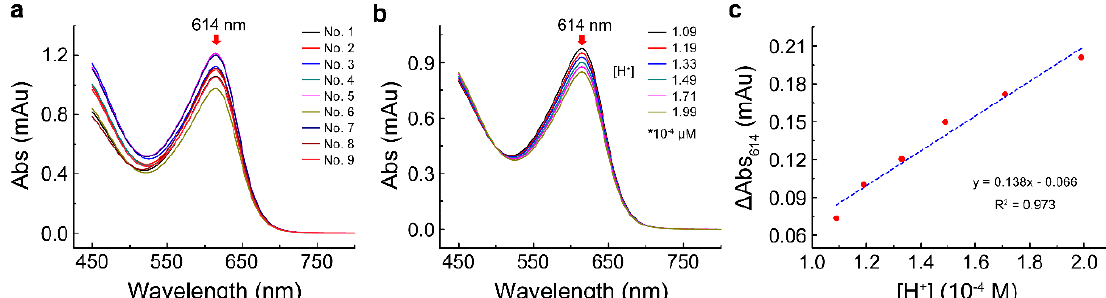
Figure 2. The maximum absorption wavelength of the reaction mixture and its relationship with the hydrogen ion concentration. ( a ) The absorption spectra of nine different combinations in the presence of 5 mM MgAC 2 ; ( b ) effect of hydrogen ion concentration on the absorption of the reaction system; ( c ) the correlation of the absorbance change of bromothymol blue at 614 nm with hydrogen ion concentration.